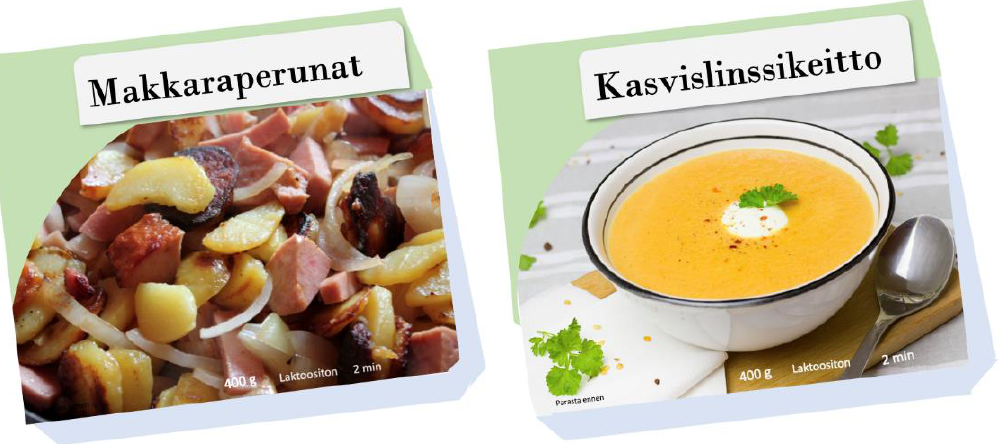
Figure 2. The sample with the unhealthy image (fried potatoes and sausages (Makkaraperunat)) and the sample with the healthy image (vegetable lentil soup (Kasvislinssikeitto)) as evaluated in the online survey.